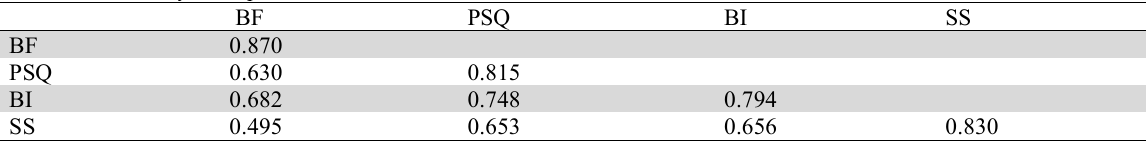
Discriminant Validity-the square root of the